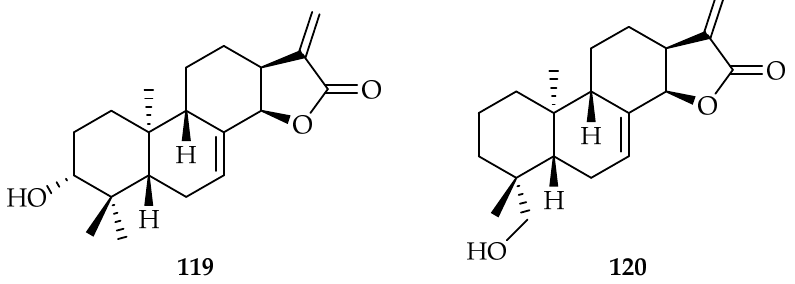
Figure 49. Structures of isoforrethins C 119 and D 120 [73].